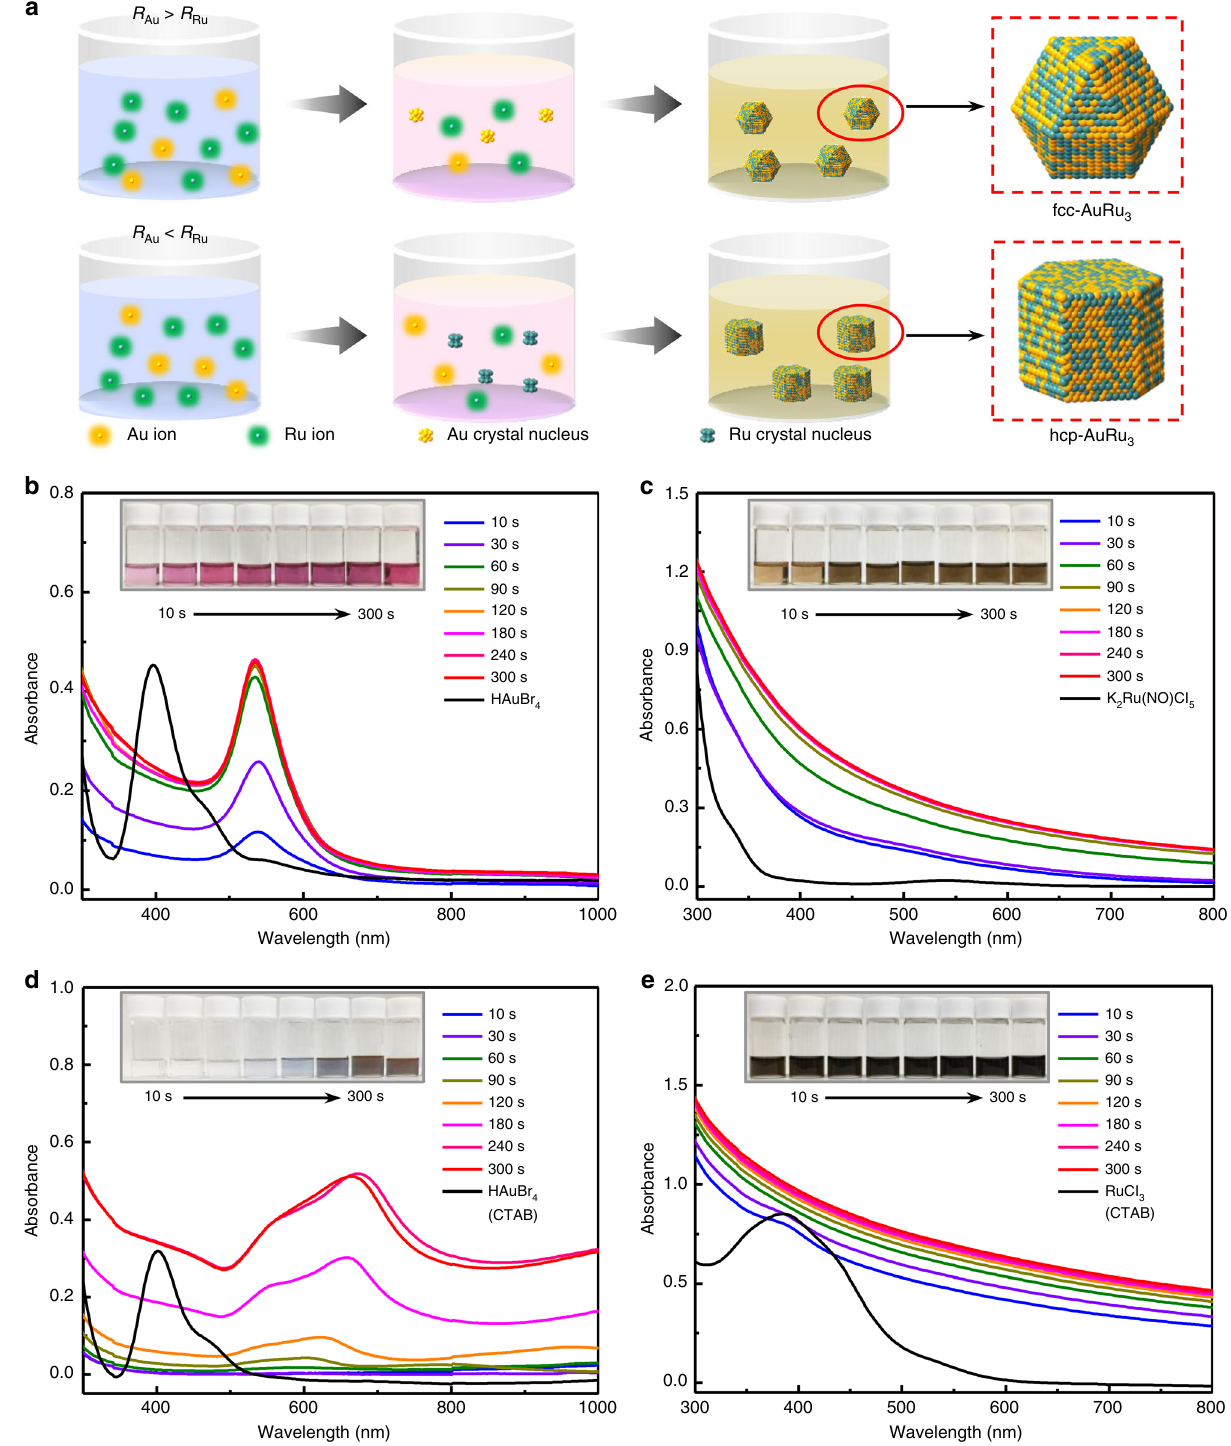
Fig. 5 Investigation of precursors' reduction speeds. a Schematic illustration of the formation process of AuRu 3 alloy NPs with fcc and hcp crystal structures. ( R Au and R Ru are the reduction speed of the Au and Ru precursors, respectively.) b , c The change in UV – vis spectra of b HAuBr 4 and c K 2 Ru (NO)Cl 5 in EG with reaction time. d , e The change in UV – vis spectra of d HAuBr 4 and e RuCl 3 with CTAB in DEG with reaction time. The inset pictures in ( b ), ( c ), ( d ) and ( e ) are the samples which were taken at different